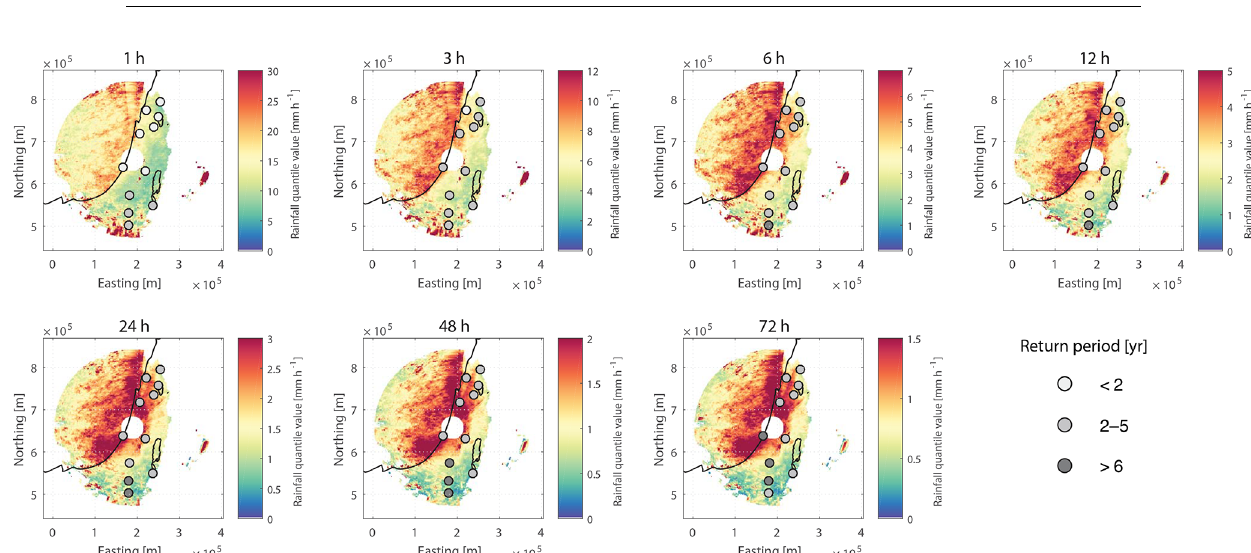
Figure 2. The 99.5% rain intensity quantile of each radar pixel for durations of 1h (top-left panel) to 72h (bottom-right panel). Notice the change in the colour scale between different durations. Also shown are annual return periods of the rain-intensity threshold averaged over nine pixels around 11 locations (generalised extreme value fit of the rain gauge annual maxima series, using the method of probability- weighted moments, with records of at least 44 years). These computed annual return periods range between 1.8 and 10.4 years. White areas found mostly to the east of the radar were masked out according to the black line in Fig. 6c (Sect.